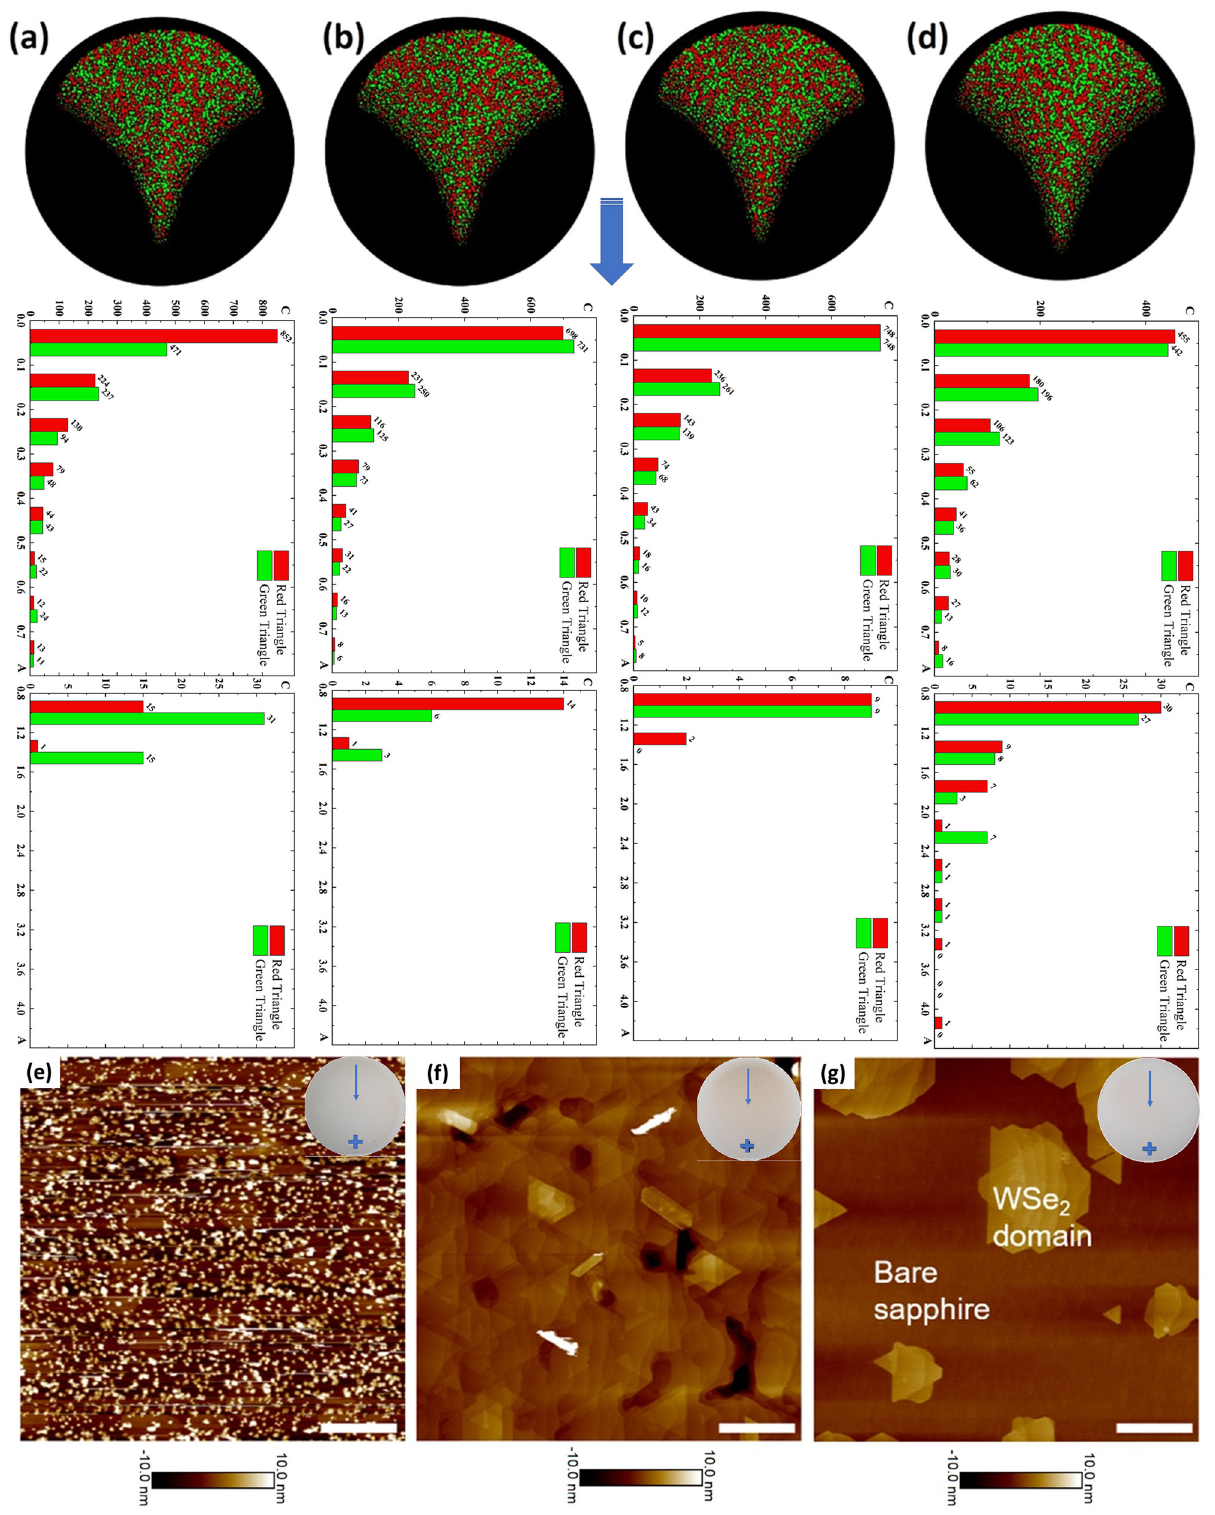
Fig. 3 Effect of growth pressure on coverage. PF simulations are performed for diffusion coef fi cients for a stationary substrate ( a ) D ¼ 10 (cid:2) 9 m 2 s (cid:2) 1 ; ( b ) D ¼ 10 (cid:2) 8 m 2 s (cid:2) 1 ; ( c ) D ¼ 10 (cid:2) 7 m 2 s (cid:2) 1 ; and ( d ) D ¼ 10 (cid:2) 6 m 2 s (cid:2) 1 . Colors show different island orientations. The abscissa shows the island area (designated A), while the ordinate shows the island count in each bin (labeled with C). Histogram of the area vs. triangles ’ count is shown, indicating larger area triangles forming at lower pressures, consistent with the AFM measurements of as-grown WSe 2 at ( e ) 500 Torr, ( f ) 200 Torr, and ( g ) 50 Torr at the point marked by ‘ + ’ on the optical images of the substrate (inset fi gures). The scale bar represents 1 μ . Arrows designate the direction of the gas fl